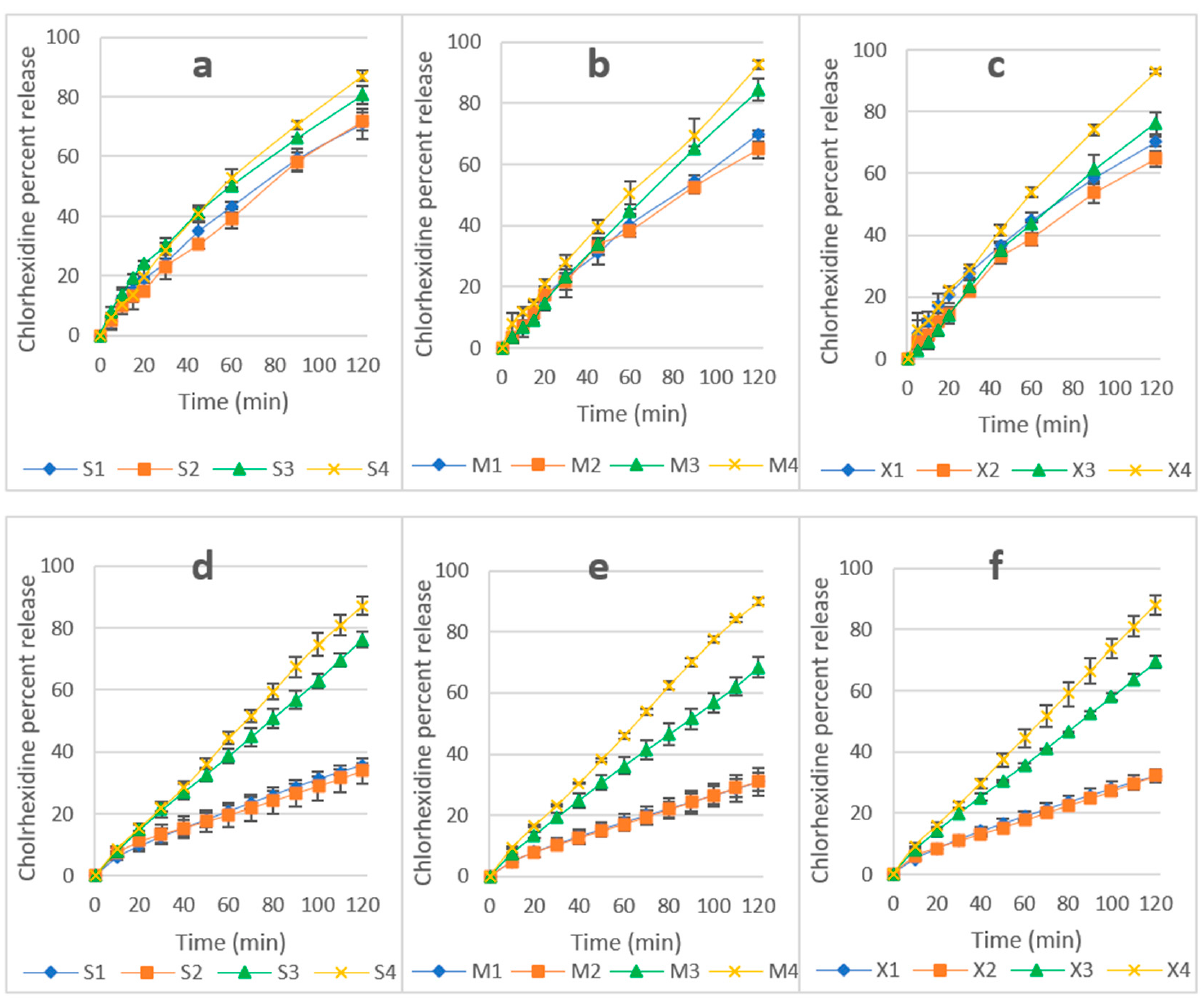
Figure 4. ( a – c ) CHD release using Apparatus I ( a —sorbitol, b —mannitol, and c —xylitol formulations). ( d – f ) CHD release using CFR ( d —sorbitol, e —mannitol, and f —xylitol). Data are expressed as mean percentages ± SD, n = 3.